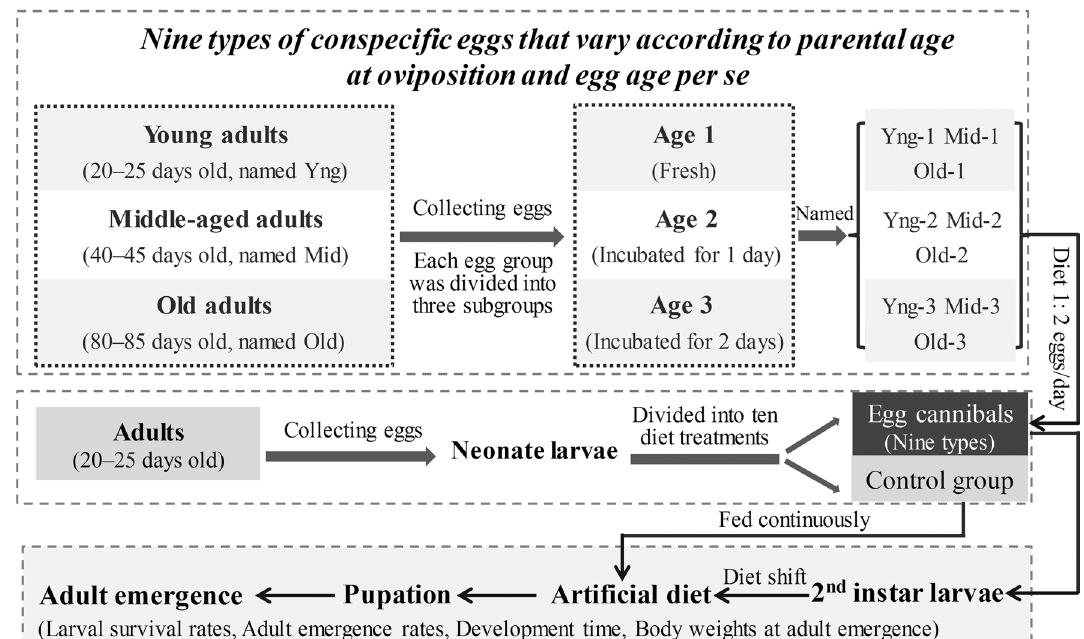
Fig. 1 The flow diagram of experimental